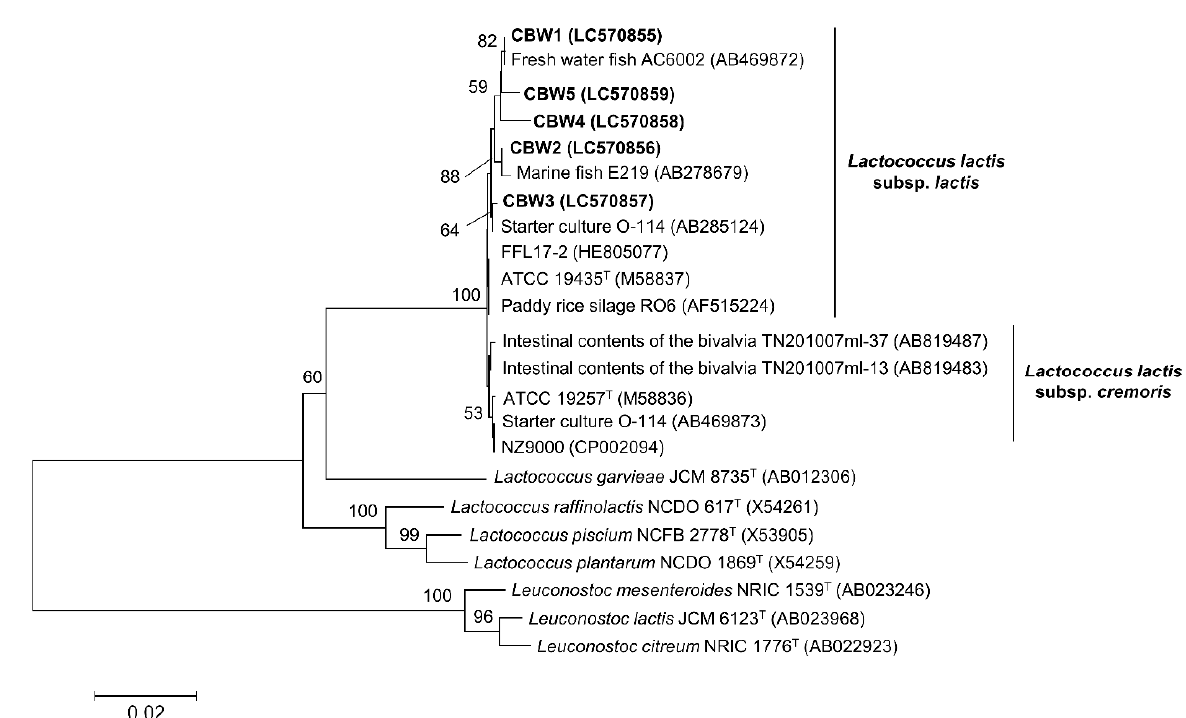
Figure 1. Phylogenetic tree generated using the neighbor-joining method and Kimura’s two-parameter model based on the 16S rRNA gene sequences (1326 bp) representing the relationships between the isolated strains CBW1–5 and related species in the genus Lactococcus . The accession numbers are shown inside the parentheses. Only >50 % bootstrap values based on 1000 replicates are shown. The scale bar represents the evolutionary distance of the nucleotide substitutions per site. Some species in the genus Leuconostoc are used as an outgroup.